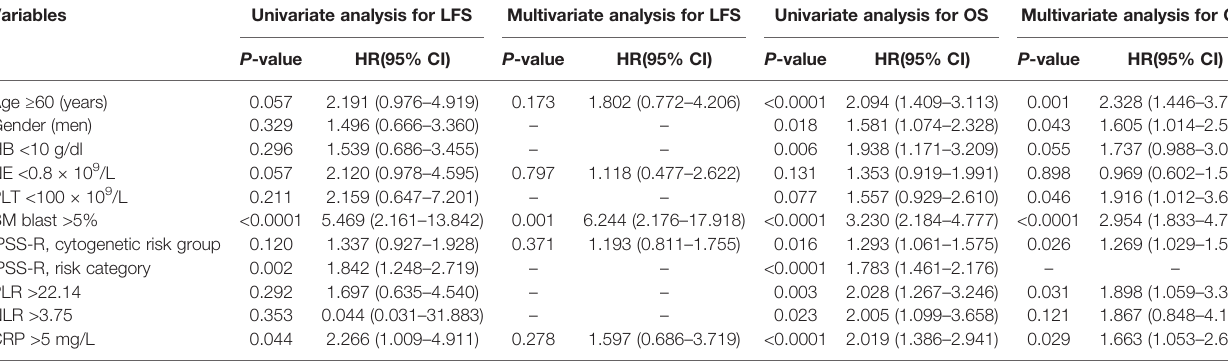
TABLE 2 | Univariate and multivariate analyses for leukemia-free survival and overall survival in 213 patients with MDS. Variables Univariate analysis for LFS Multivariate analysis for LFS Univariate analysis for OS Multivariate analysis for